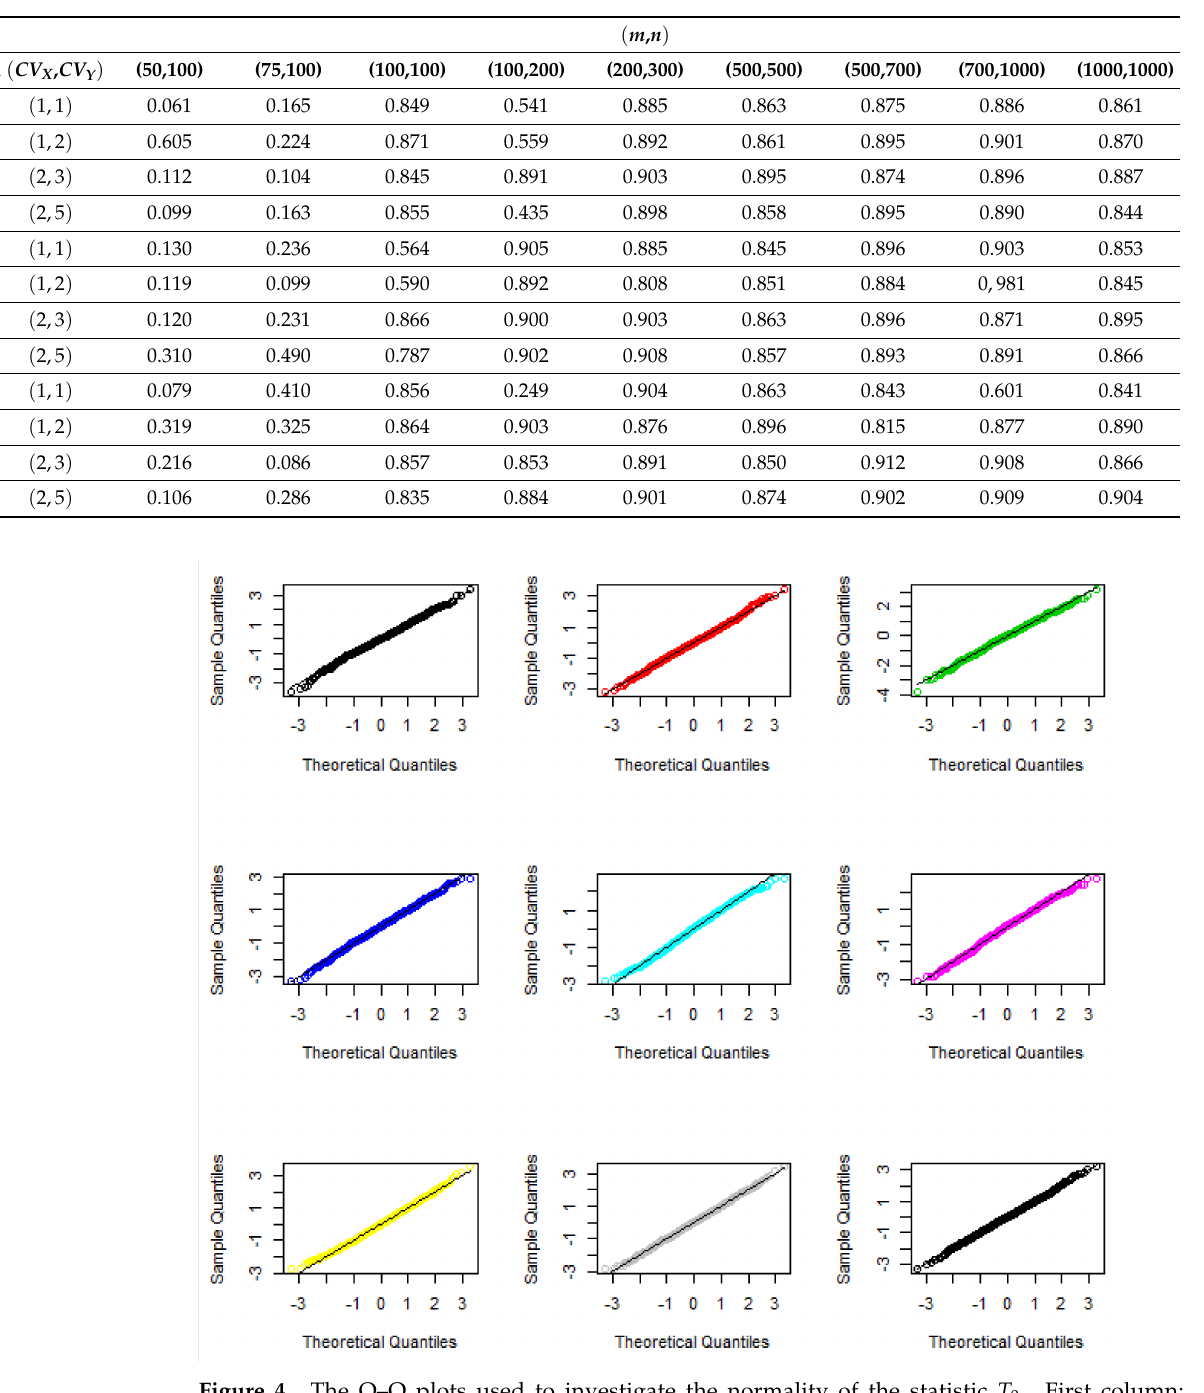
Table 4. The p -values to investigate the normality of the statistic T 0 .